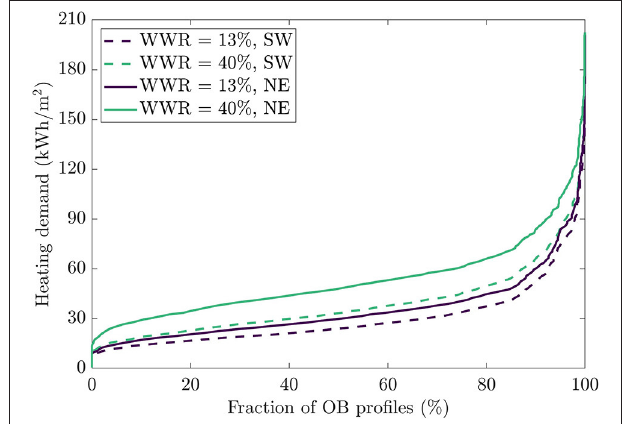
FIGURE 11 | Cumulative fraction of possible occupant behavior scenarios with a specific heating demand for two orientations and two window-to-wall ratios.